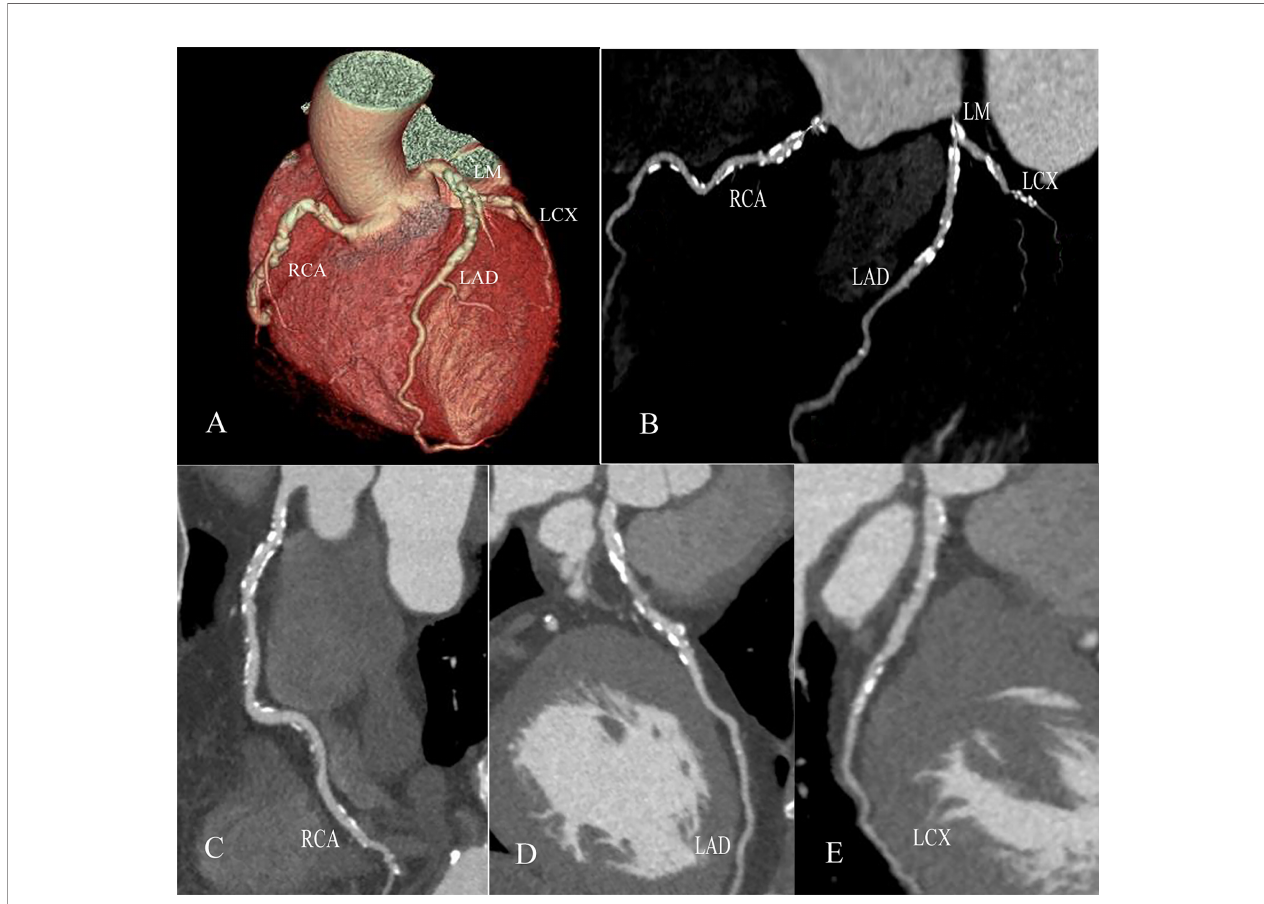
FIGURE 4 | Multivessel disease in a male with type 2 diabetes mellitus with a 40-year smoking history. Volume rendering image (A) , two-dimensional CT image (B) and curvature plane reconstruction images (C – E) show the nonsmooth edges and diffuse calci fi ed and mixed plaques of the LM, LAD, RCA and